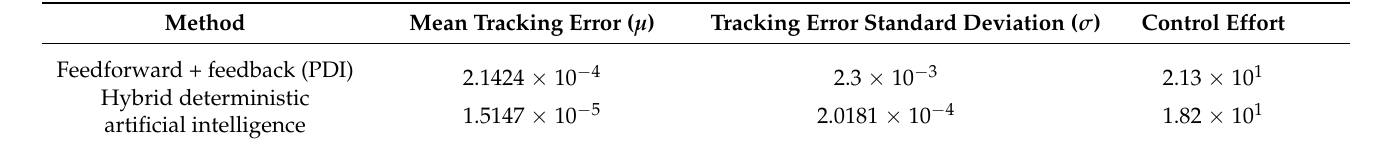
Figure 2. ( a ) Thirty degree yaw feedforward plus feedback (FFD + FB) control, ( b ) thirty degree yaw hybrid deterministic artificial intelligence (DAI) control. Both figures include display of tracking errors in the zoomed-inset graphic. Notice the ordinate scale, respectively of insets in subfigure ( a , b ) to reveal the relative comparison. Table 6. Figures of merit for nominal thirty degree yaw 1